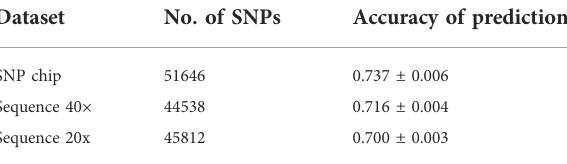
TABLE 3 Accuracy of prediction for dataset-1 – DNA pooling of samples.